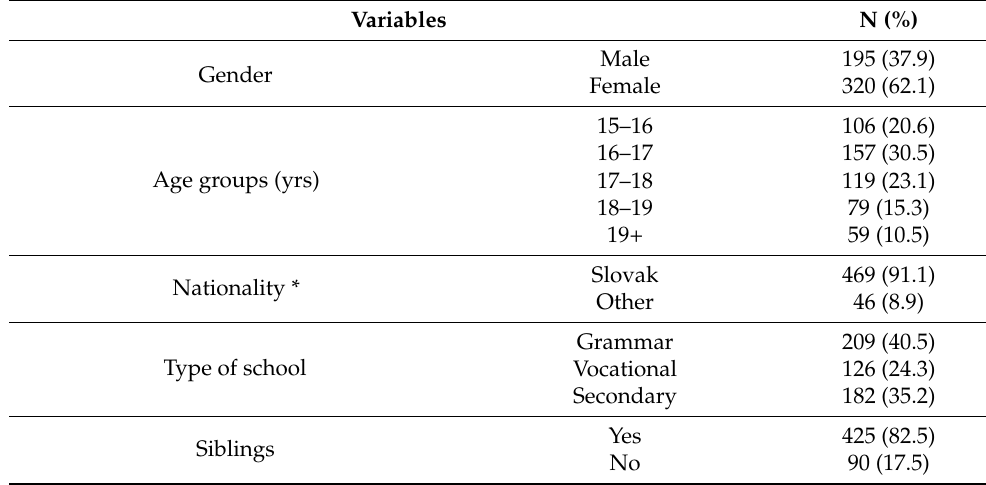
Table 1. Characteristics of the students ´ sample ( n = 515)